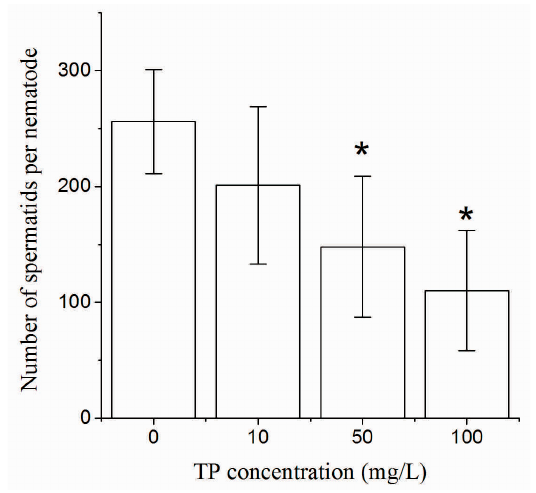
Figure 5. The number of spermatids per nematode exposed to TP for 4 h. TP, Triptolide. Bars represent means ± SEM. * p < 0.05 vs. the control group.